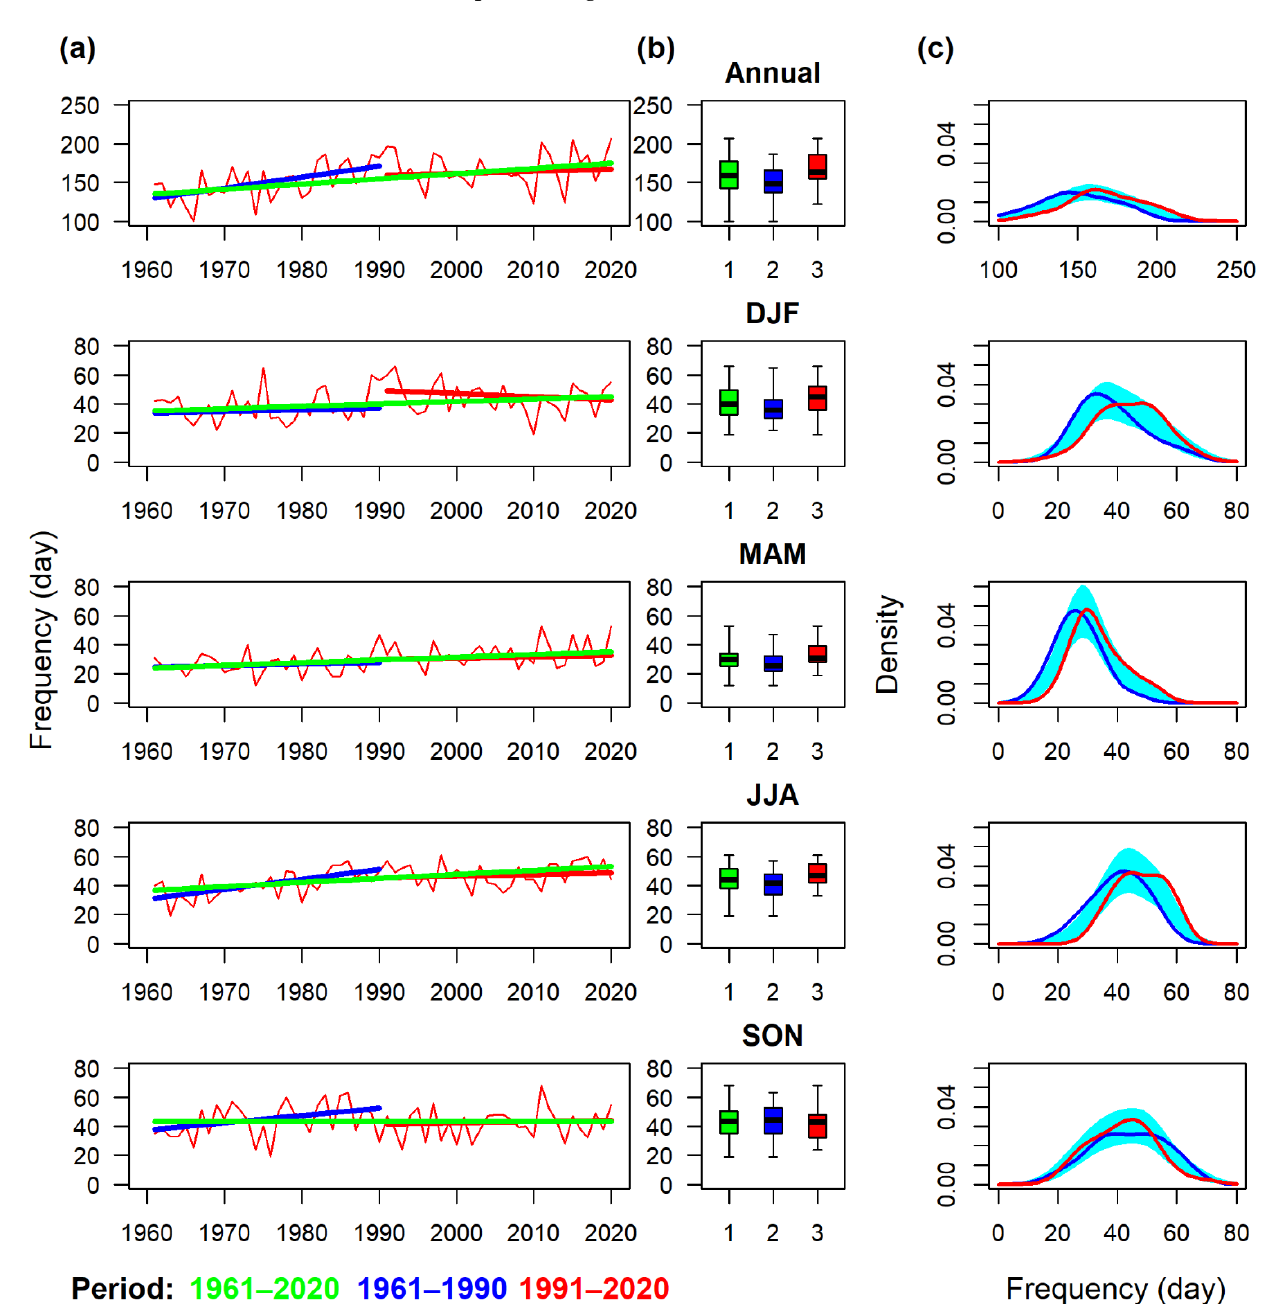
Figure 2. Annual and seasonal frequencies of days with anticyclonic circulation types according to the objective classification for the territory of the Czech Republic in the 1961–2020 period: ( a ) fluctuations with linear trends in the entire period, 1961–1990 and 1991–2020; ( b ) box plots (median, lower and upper quartile, minimum, and maximum) for 1961–2020 (1), 1961–1990 (2), and 1991–2020 (3); ( c ) the density distribution of the series in 1961–1990 and 1991–2020. The density curves outside the reference band (green–blue) indicate a significant difference in the two distributions (and vice